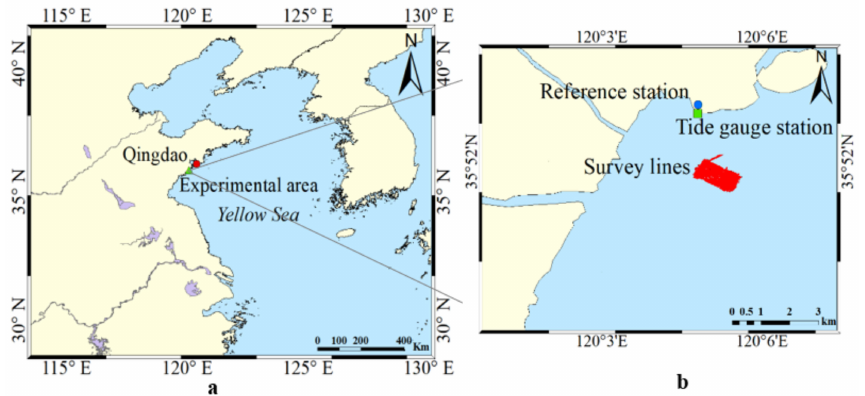
Figure 5. Experimental area near Qingdao, China. ( a ) Locations of Qingdao and the experimental area; ( b ) Locations of GPS reference station, tide gauge point, and survey lines.